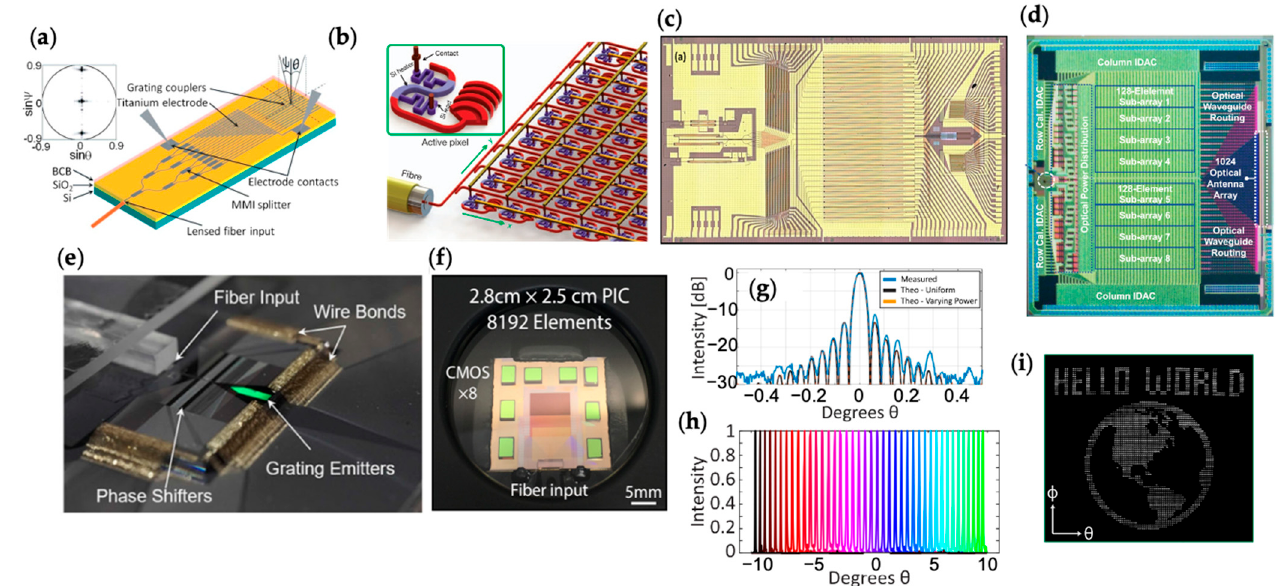
Figure 2. Implementations of silicon photonic OPAs. ( a ) Schematic of a 1D OPA combined with grating emitters. Reprinted with permission from [16] © The Optical Society. ( b ) Schematic of a 2D OPA. Reprinted with permission from Springer Nature: Nature [29] © Springer Nature (2013). ( c ) Optical image of a 32-element OPA on a heterogenous III-V/silicon photonic platform. Reprinted with permission from [15] © The Optical Society. ( d ) Optical image of a 1024-element OPA monolithically integrated with the electronics. © 2022 IEEE. Reprinted with permission, from [14]. ( e ) Optical image of a 512-element OPA wire-bonded to the driving electronics. Reprinted with permission from [12] © The Optical Society. ( f ) Optical image of an 8192-element OPA with co-packaged flip-chip CMOS drivers. Reprinted with permission from [13]. Copyright © 2022, Poulton et al. ( g – i ) Measured far-field angular distribution, beam steering to different angles, and scanning pattern from an OPA. Reprinted with permission from [9] © 2022 IEEE.